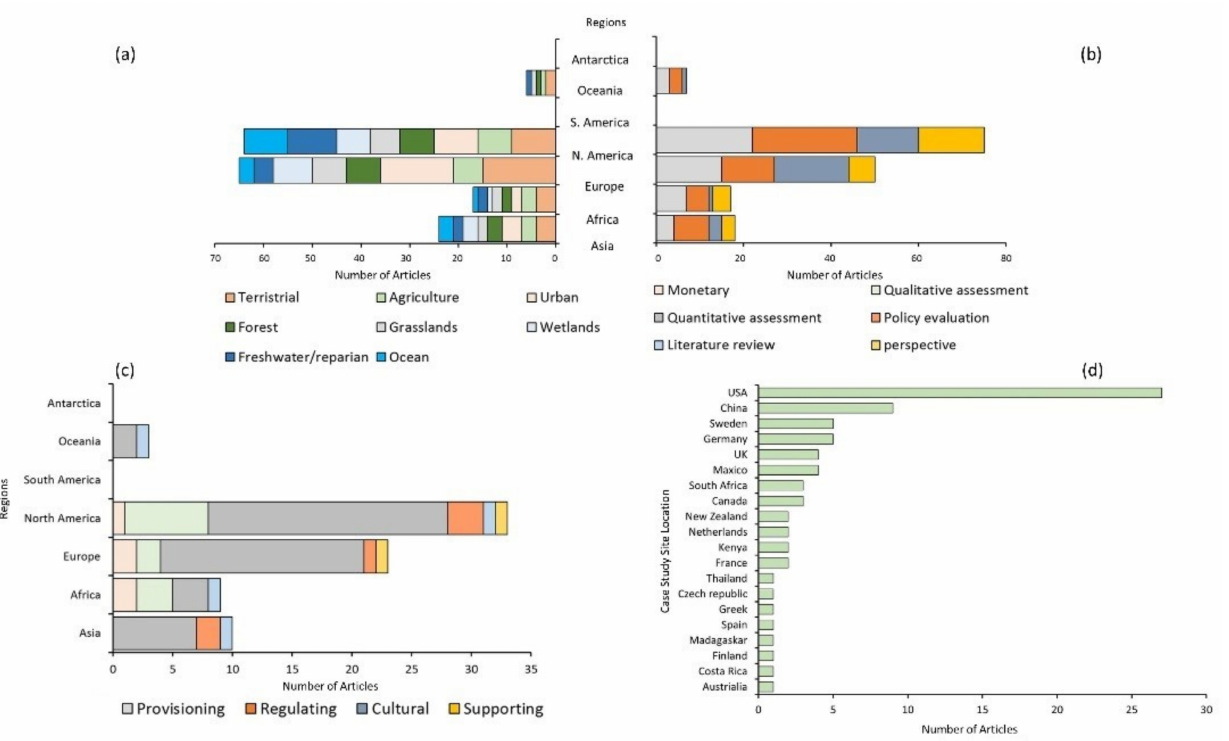
Figure 7. Highly cited articles: ( a ) Ecosystem Type, ( b ) Services of Ecosystem, ( c ) Research interest, and ( d ) Geographical locations of the study